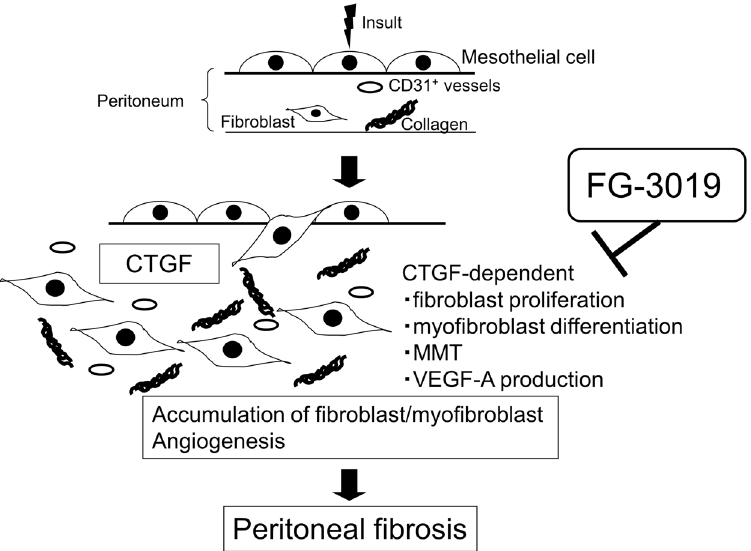
Figure 9. Proposed schema for the development of peritoneal fibrosis regulated by CTGF. CTGF contributes to multiple processes fundamentally involved in the pathogenesis of peritoneal fibrosis, including the induction of fibroblast proliferation, myofibroblast differentiation, MMT and VEGF-A production, in an autocrine and/ or paracrine manner. Targeting CTGF using FG-3019 may therefore be an effective therapeutic strategy for peritoneal